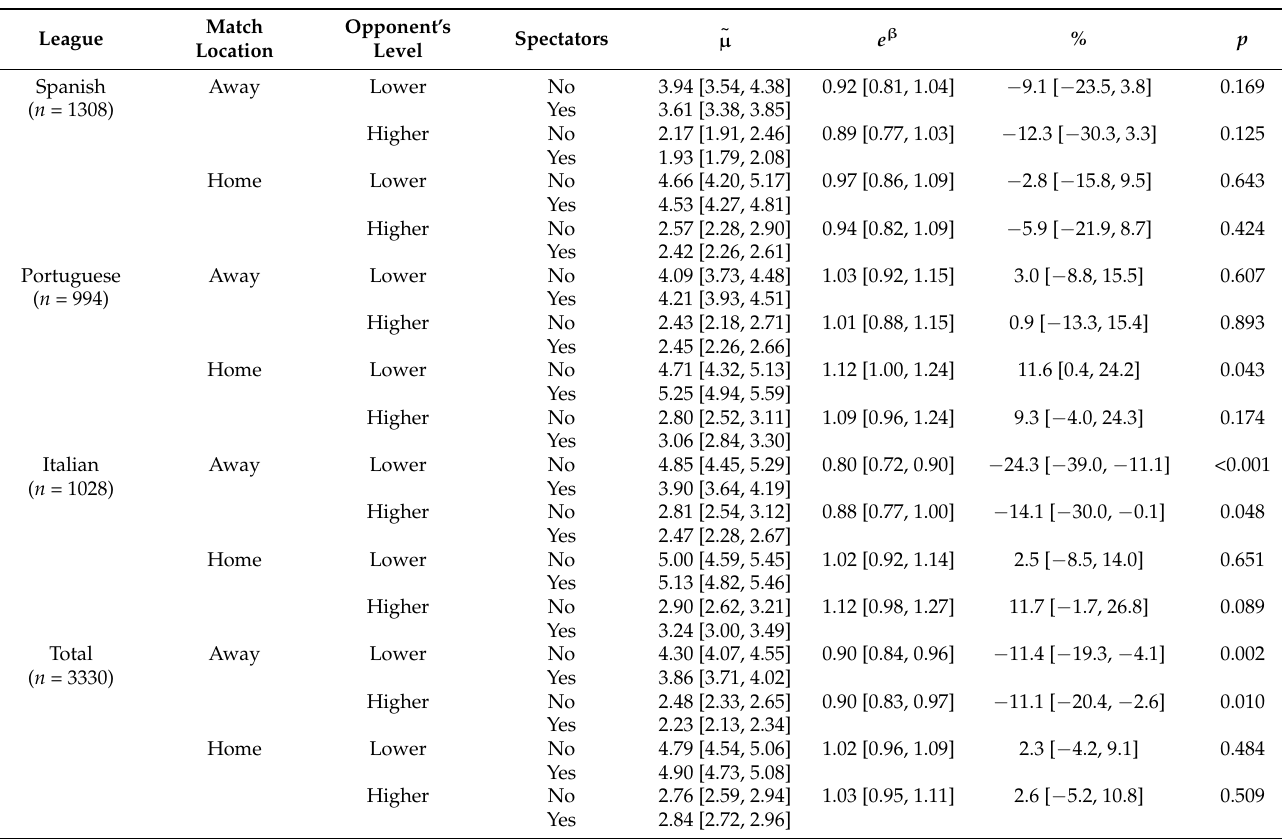
Table 3. Effect of playing with spectators on the number of goals scored in different leagues and competitive situations.